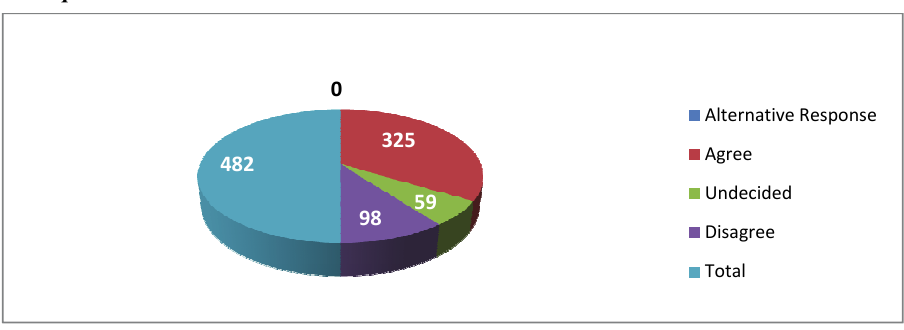
Pie Chart 9: Represent Views of respondents on whether there is any relationship between merit and competency based academic staff recruitment and human capital development